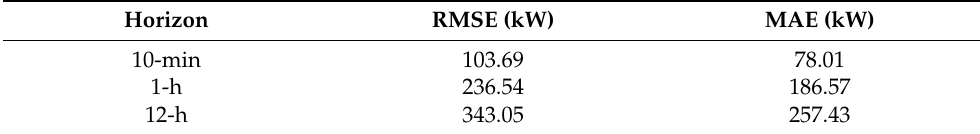
Table 10. Summary of the adjusted models for the three horizons.